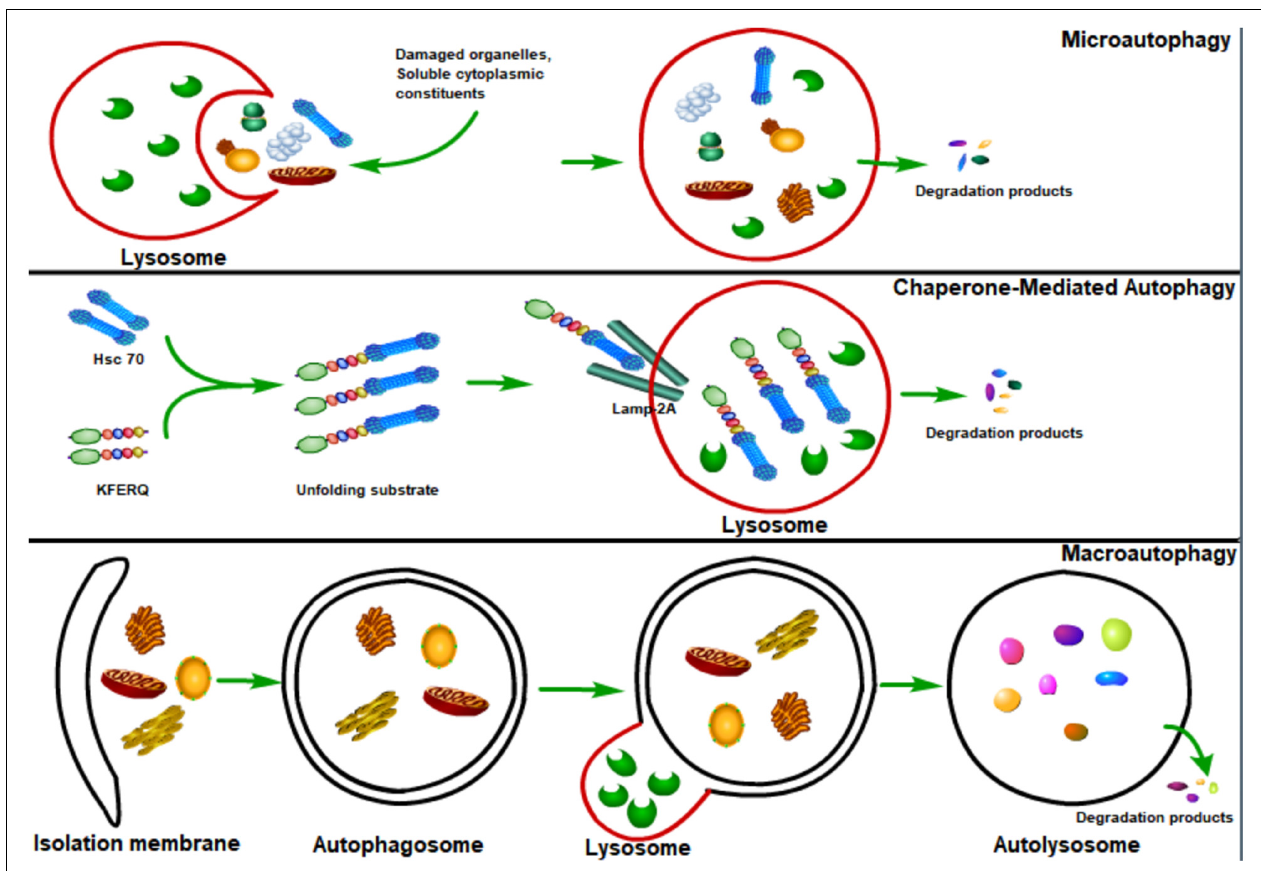
FIGURE 1 | Major types of autophagy. According to the way that eukaryotic cells deliver cytoplasmic cargo to lysosomes for degradation, autophagy can be divided into three major types: macroautophagy, microautophagy, and chaperone-mediated autophagy (CMA). Microautophagy refers to the lysosome itself engulfing cytoplasmic material or large structures by invading the lysosome membrane. The CMA only degrades soluble proteins in a selective manner through the LAMP2A receptor on the lysosome to recognize and translocate unfolding proteins with a specific signal sequence—KFERQ. Macroautophagy could both selectively and non-selectively engulf bulk cytoplasmic components by sequestering these cargoes to a specialized double-membrane vesicle known as the autophagosome; autophagosome is then fused with the lysosome, where the cargo is degraded and the resulting macromolecules are released into the cytosol for